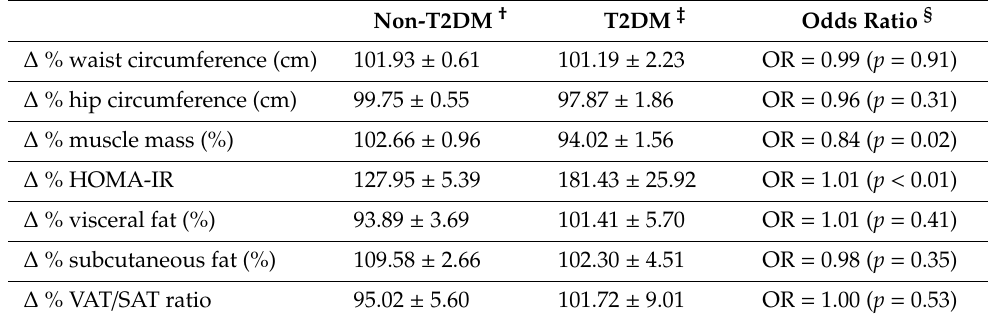
Table 5. Descriptive statistics, odds ratios, and corresponding p -values in the prospective study estimated using age-adjusted generalized linear models with the logit link